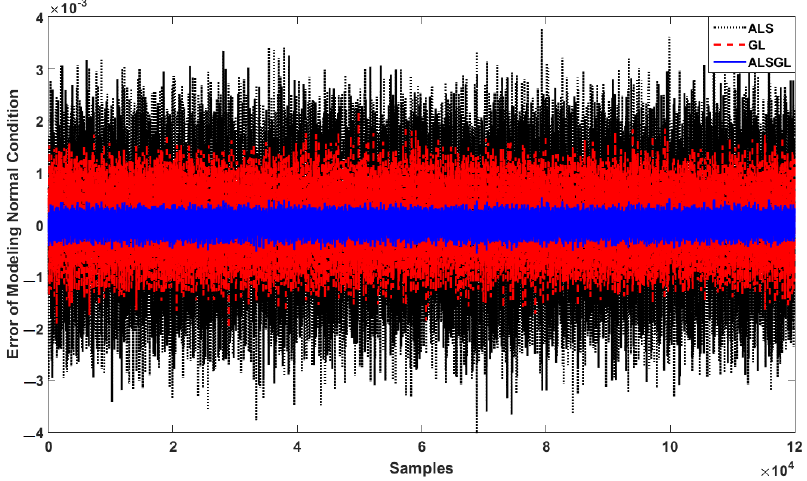
Figure 8. Error of AE signal modeling using ALS, GL and proposed ALSGL approaches.